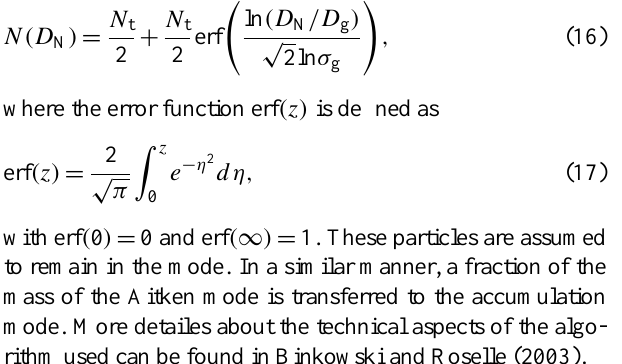
Fig. 3: Destination mode of each possible coagulation event in MADE-in. The first row and the first column show the coagulating